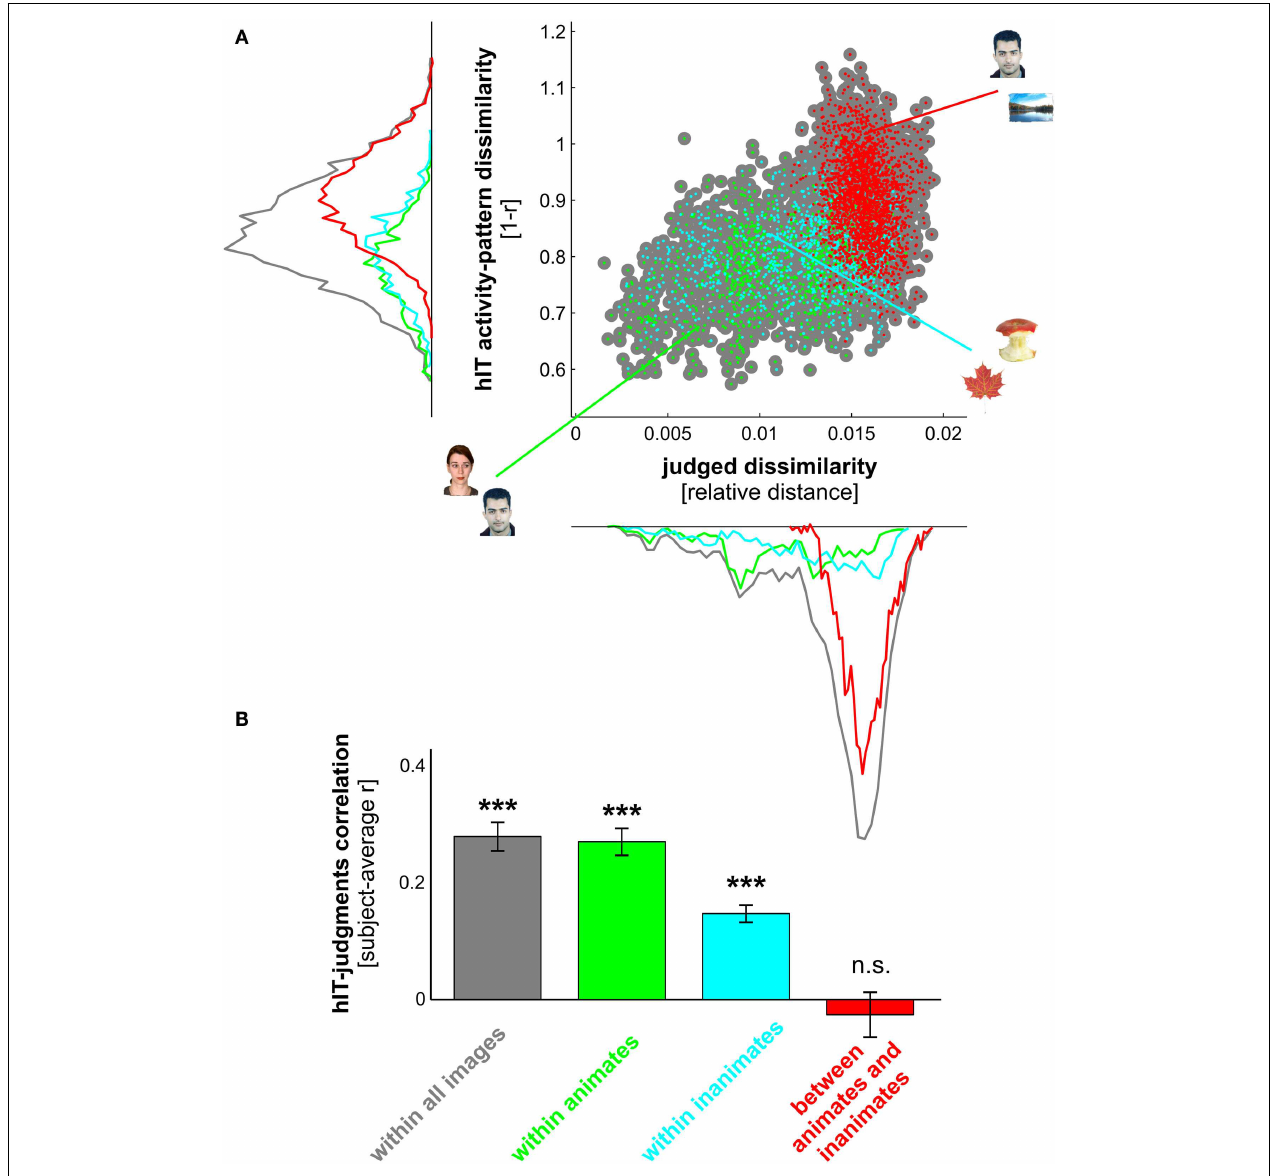
( r =− 0.16, p < 0.9975). Consistent with the results in Figure 3 , the marginal histograms show that both hIT and judged dissimilarities are larger for object pairs that cross the animate-inanimate category boundary (red) than for object pairs that do not cross this boundary (green and cyan). (B) To test whether the continuous match between hIT and judged dissimilarities would generalize to the population of similarity judgment subjects, we computed the correlation of each single-subject judgment RDM with the subject-average hIT RDM and tested whether the average of those correlations was significantly larger than zero, using a one-sample t test. Bars show the average correlation between hIT and judged dissimilarities across subjects. Error bars show SEM. Asterisks indicate significance ( p < 0.001).